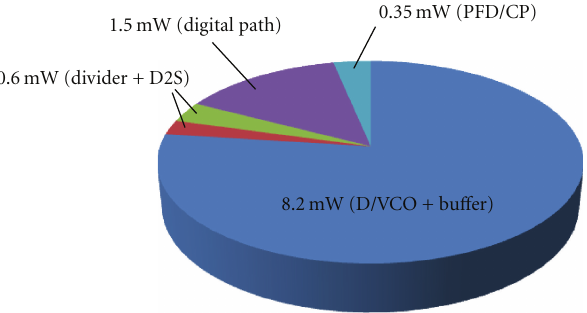
Figure 16: Power consumption